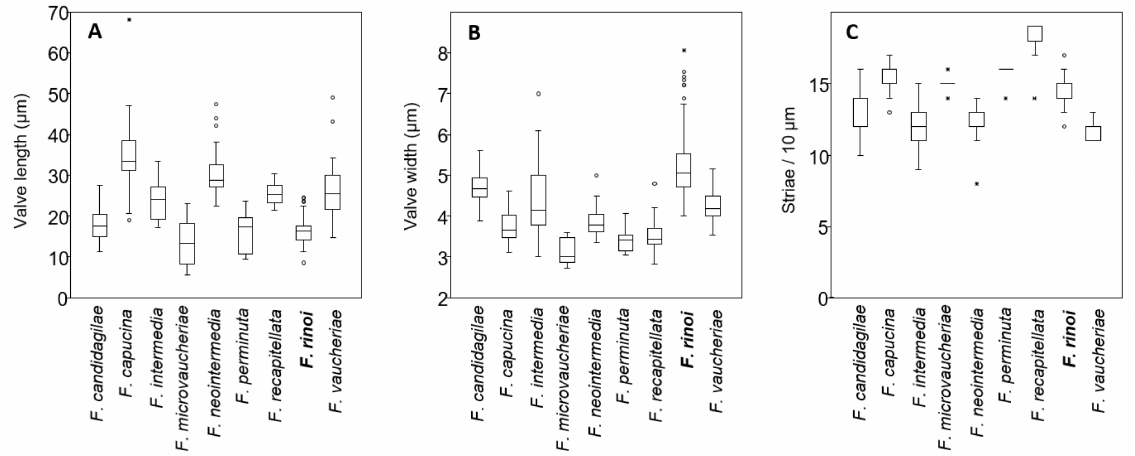
Fig. 92. Boxplot of measurements of different Fragilaria species. Variation in valve length (a), width (b) and striae in 10 μm (c) measured in the type populations. The boxes represent the 25–75% quartiles, the median is shown with a horizontal line inside the box, and minimum and maximum values are shown with short horizontal lines (whiskers). Outliers are plotted as individual points.